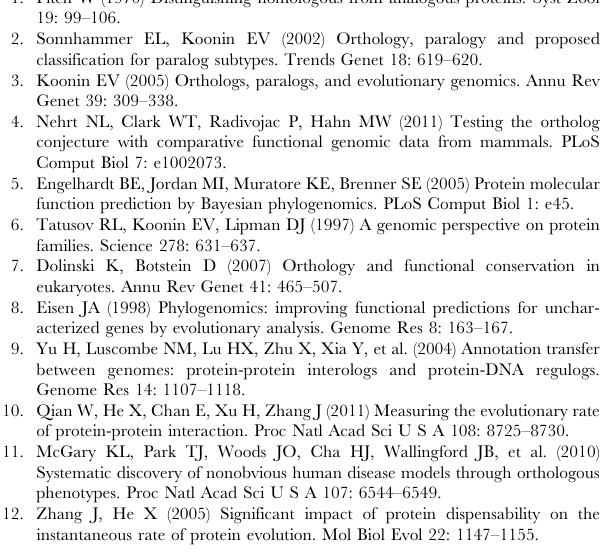
(J-R) within-mouse paralogs across nine tissues. Numbers on the X-axis correspond to the branches in Fig. 5A. Error bars indicate one standard error. The dashed line indicates the human-mouse divergence. (PDF) Figure S9 Rank-based expressions are generally more similar for human-mouse orthologs than (A-J) within-human paralogs and (K-T) within-mouse paralogs across 10 tissues. Numbers on the X- axis correspond to the branches in Fig. 5A. Error bars indicate one standard error. The dashed line indicates the human-mouse divergence. Table S1 Numbers of gene pairs used in the time series analysis (Fig. 1 and Fig. S2). Note that the gene pairs used are the same across all years. Table S2 Human and mouse homologous genes with identical protein sequences in co-study papers. Table S3 Numbers of gene pairs used at each level (bin) of sequence identity in human and mouse RNA-Seq analysis (Fig. 3). Table S4 Numbers of gene pairs used at each level (bin) of sequence identity in the multiple-species RNA-Seq analysis (Fig.